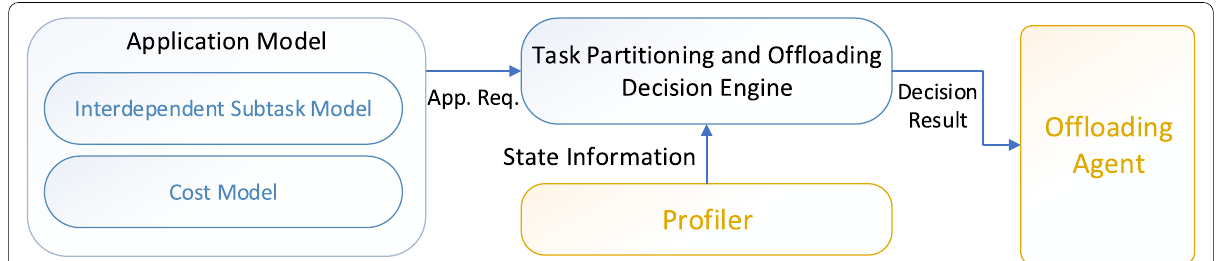
Fig. 7 The general framework and workflow of task partitioning and